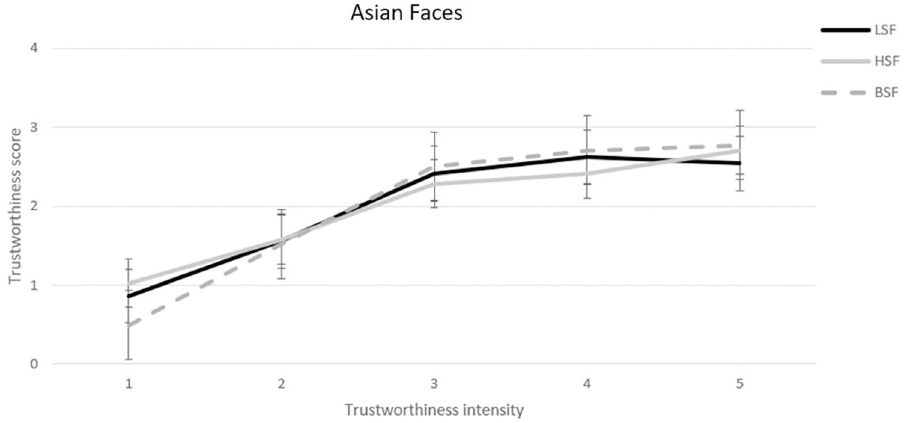
Fig 4. Mean trustworthiness scores for each of the five Asian faces composing the trustworthiness continuum in the Low-Spatial-Frequency (LSF), the High-Spatial-Frequency (HSF), and the Broad-Spatial-Frequency (BSF) conditions. Error bars refer to standard errors of the means.